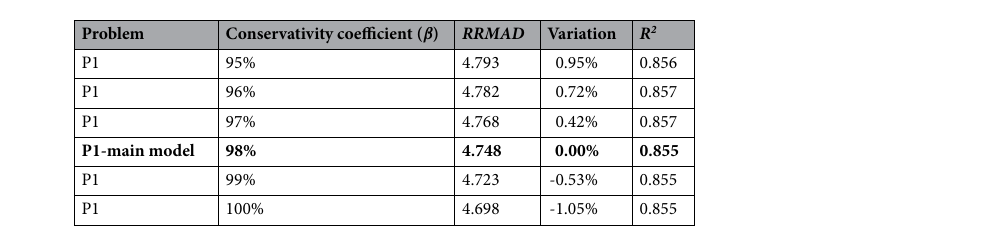
Table 6. Analyzing of conservativity coefficient. Significant values are in